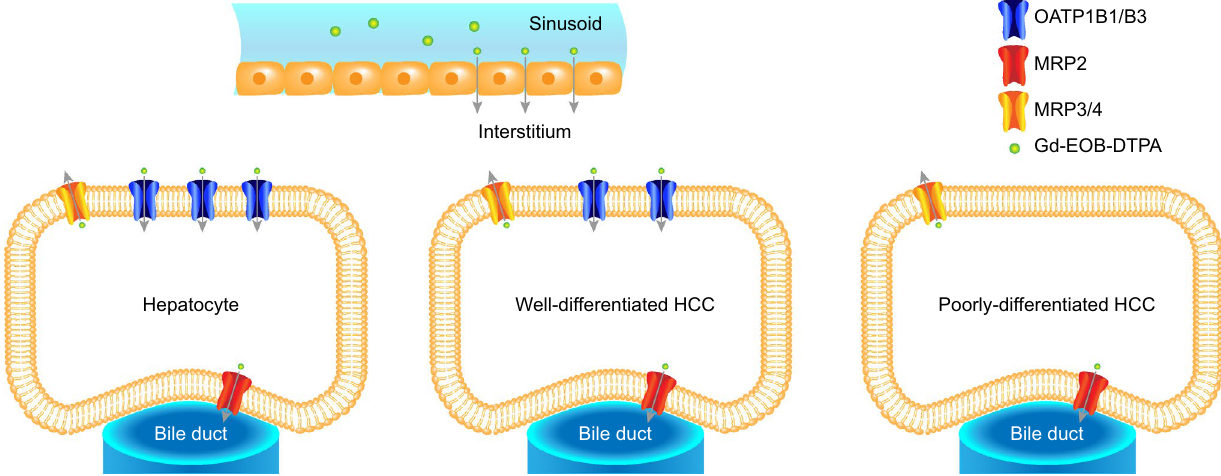
Figure 1. Gd-EOB-DTPA uptake. In healthy hepatocytes, the hepatobiliary contrast agent Gd-EOB-DTPA is distributed from sinusoidal spaces into the interstitium and consecutively into hepatocytes. Gd-EOB-DTPA sinusoidal clearance into the liver is controlled by the transport of organic anion-transporting polypeptides (OATPs). Absorbed Gd-EOB-DTPA passes from hepatocytes into the bile canaliculi and partially returns to the interstitium with the help of multiple resistance-associated proteins (MRP1); this intercompartmental transfer generates a ratio between the sinusoids, interstitium, hepatocytes, and bile canaliculi. In tumor cells, the expression of MRP is often maintained, whereas the expression of OATP1B1/B3 tends to decrease over the course of hepatocarcinogenesis 14